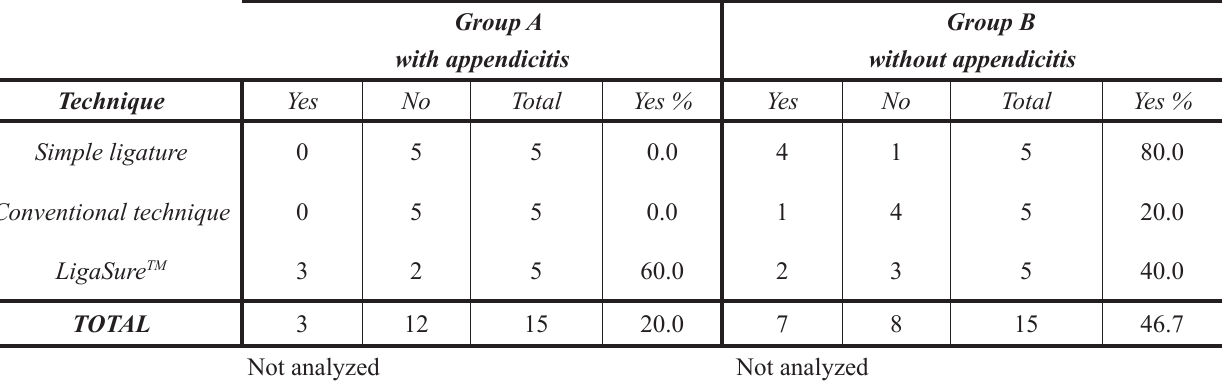
TABLE 4 - Rabbits from groups A and B in the three operative techniques for acute inflammatory process (Figure 1).